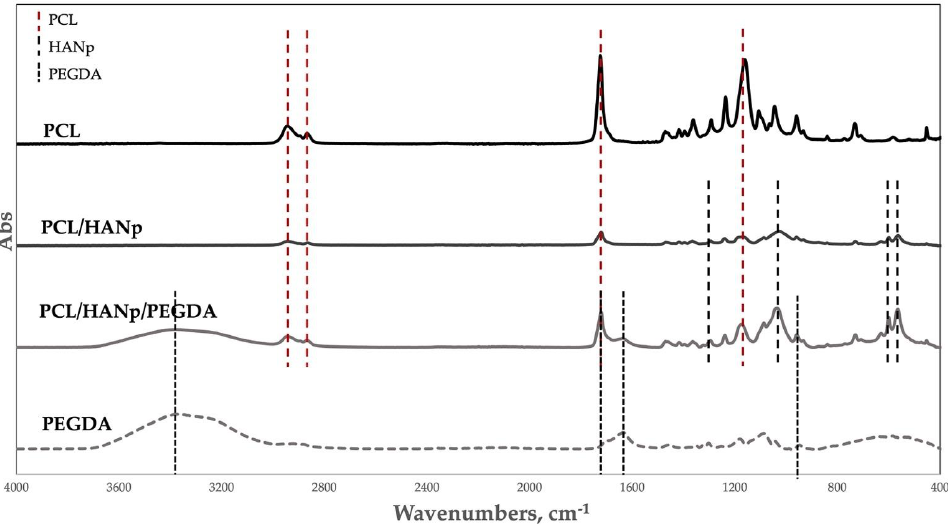
Figure 3. FTIR spectra of each group (PCL, PCL/HANp, PCL/HANp/PEGDA and PEGDA).